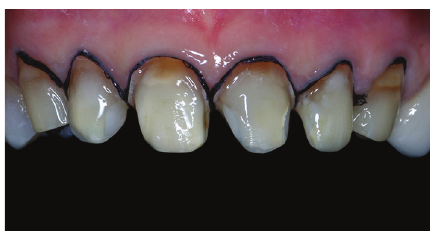
Figure 12: Dental preparation 9 months after periodontal plastic surgery.